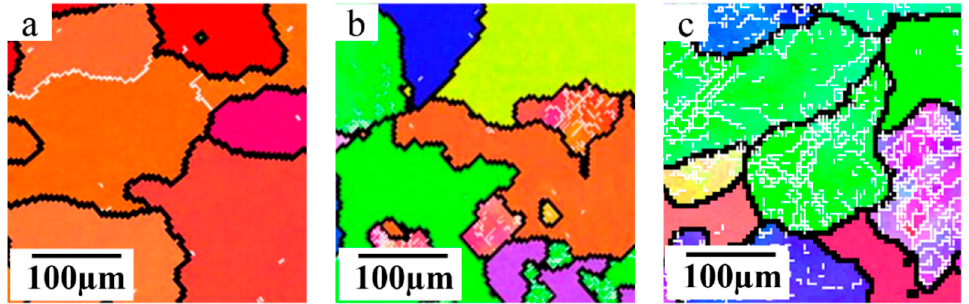
Figure 5. Electron backscatter diffraction (EBSD) orientation maps showing the sub-grain of TiC/2219